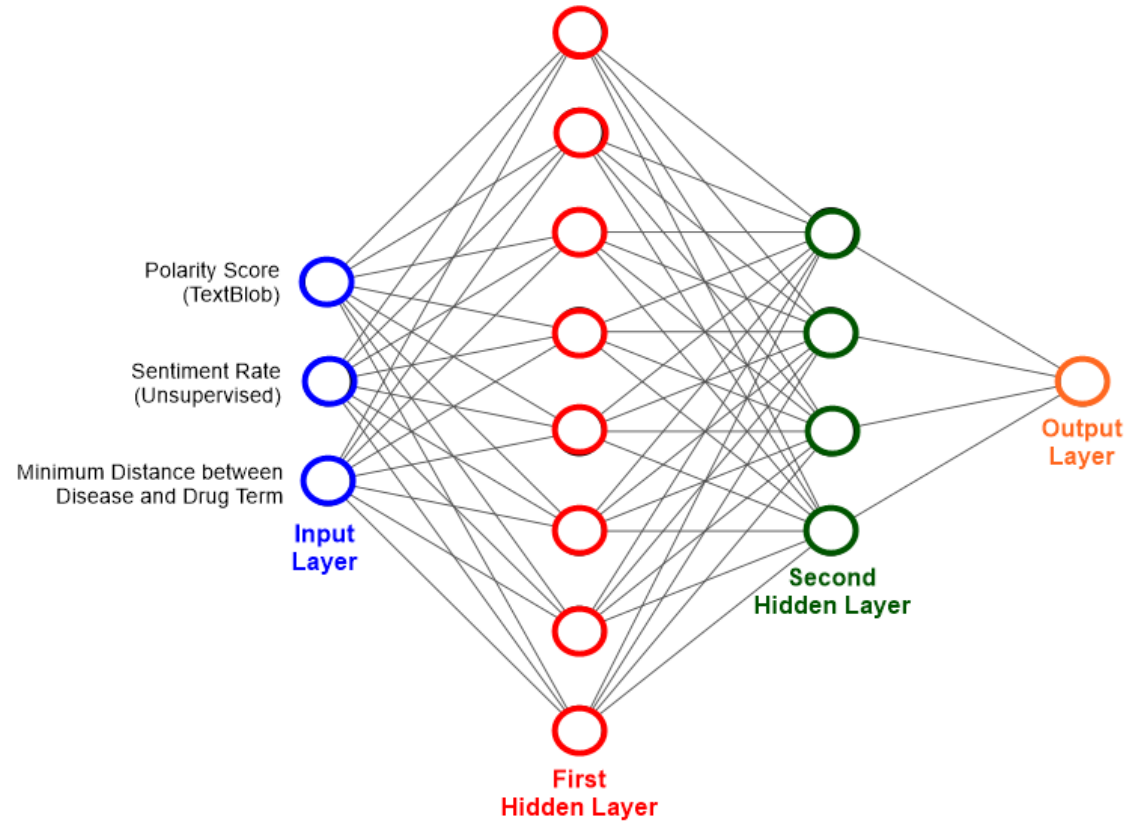
Figure 2. Schematic diagram of the deep neural network used to predict the effectiveness of drugs against